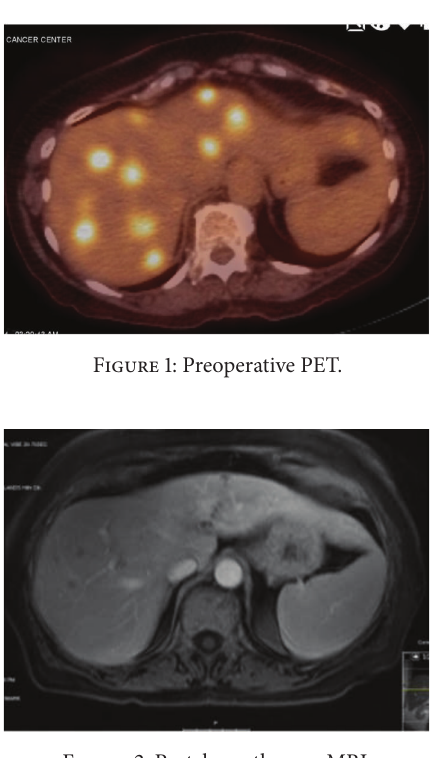
Figure 2: Postchemotherapy